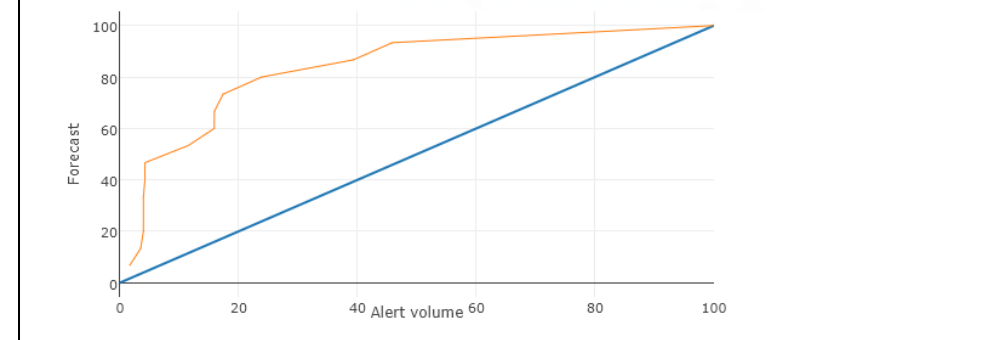
Figure 5. Fragment of description of the forecast results in GIS Prognosis.